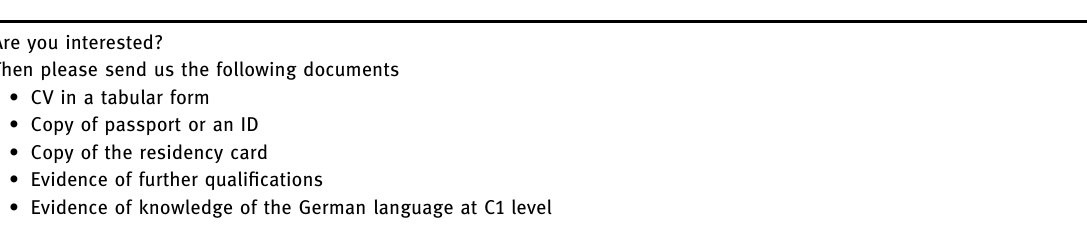
Table 3: Required documentation to become an interpreter for the Bamf ( author ’ s translation )